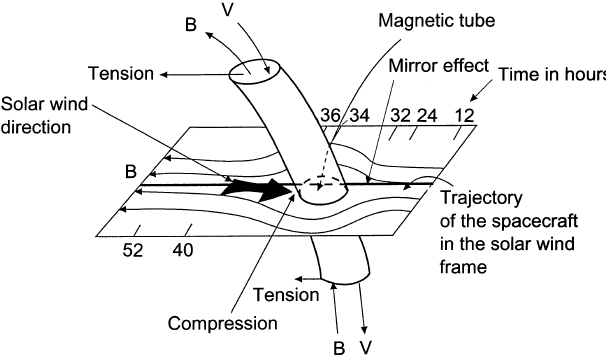
Fig. 5. Sketch of the assumed or inferred plasma flow (indicated by the thick large arrow ) and magnetic-field geometry during the observed pressure enhancement, interpreted as evidence for an interplanetary magnetic flux rope that is partially convected by the flow, which by pushing on the tube maintains it in dynamic equilibrium. The Sun is to the left, which is the